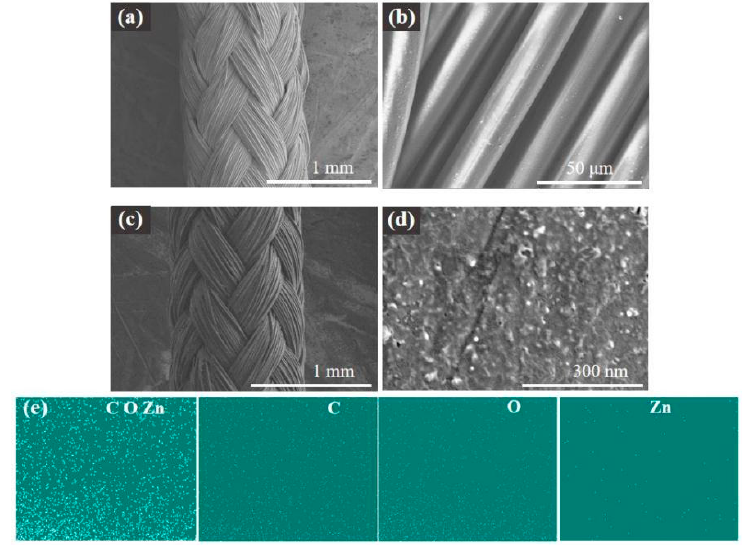
Figure 3. SEM images of ( a , b ) the nylon fiber and ( c , d ) the rGO/ZnO-5 nylon fiber sensor. ( e ) An EDS image.